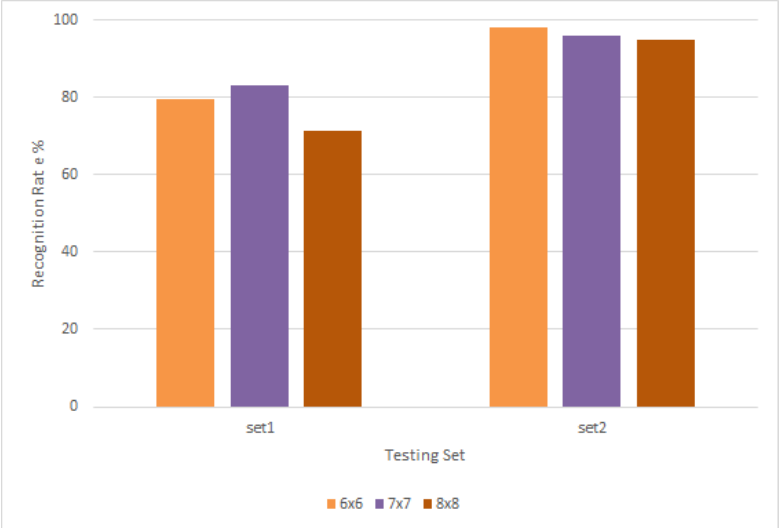
Figure 10. Results of experiments conducted using different HOG